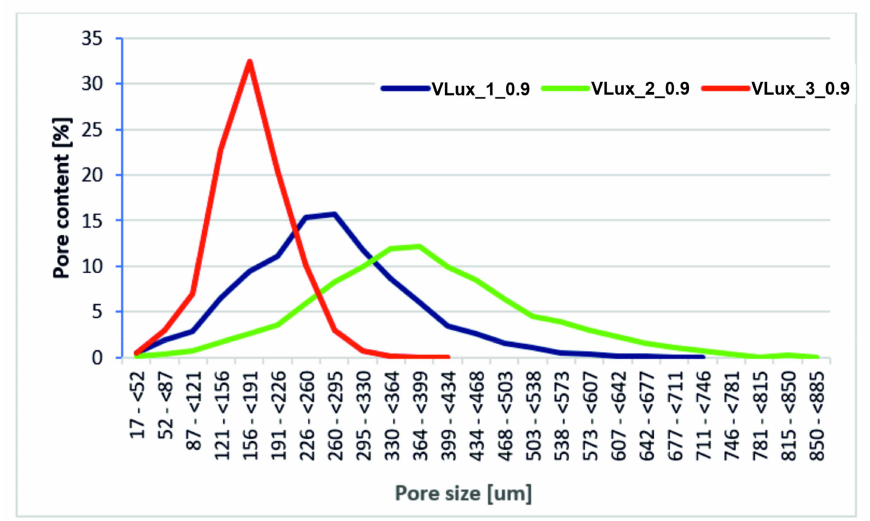
Figure 9. The results of the pore size analysis of foams with different water content performed at INCO = 0.9 were obtained during the analysis with the use of µ CT.